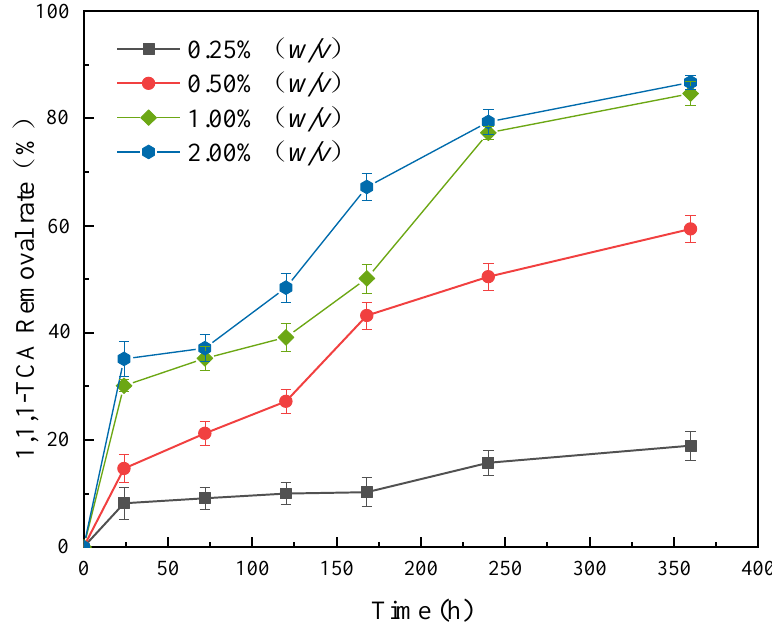
Figure 6. Effect of composite dosage on 1,1,1-TCA removal (mass fraction of nZVI: 20%; 1,1,1-TCA concentration: 100 mg·L −1 ).